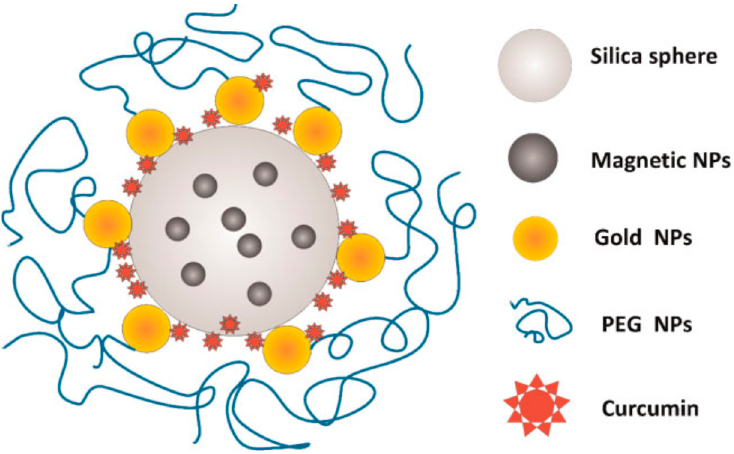
Figure 1. A diagram illustrating the structure of the Fe 3 O 4 @Au nanoparticles. Reprinted with permission from [20]. Copyright WILEY-VCH, 2010.